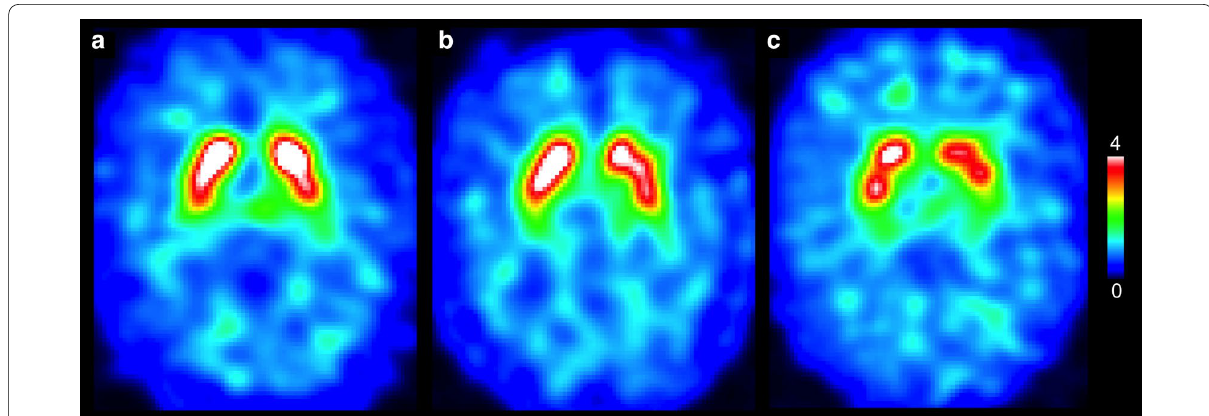
Fig. 2 Three representative striatal level [ 123 I]FP-CIT SPECT images from three subjects. A Image evaluated visually as normal, but semiquantitatively abnormal (Subject 8 in Table 2, male). B Image evaluated visually as borderline, but semiquantitatively abnormal (Subject 6, female). C Image evaluated visually and semiquantitatively abnormal (Subject 12,